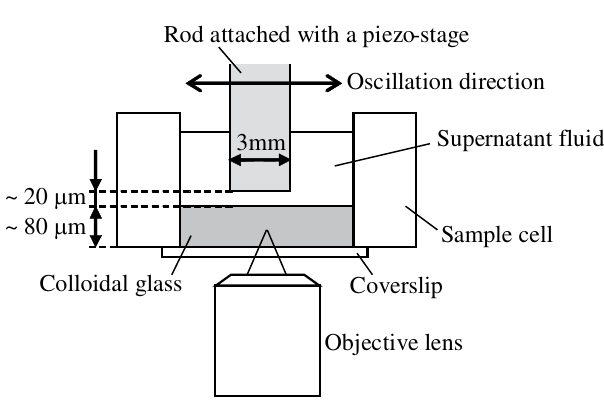
Figure 6. Schematic image of experimental setup.